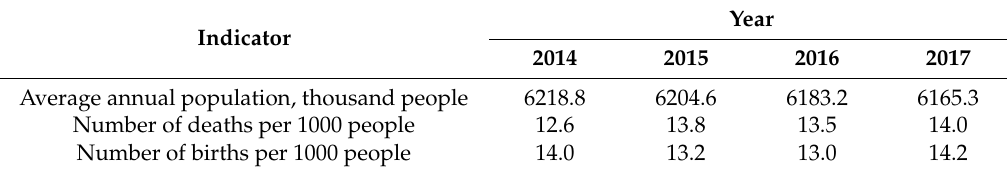
Table 1. Main demographic indicators of the population of the Far Eastern region in 2014–2017.